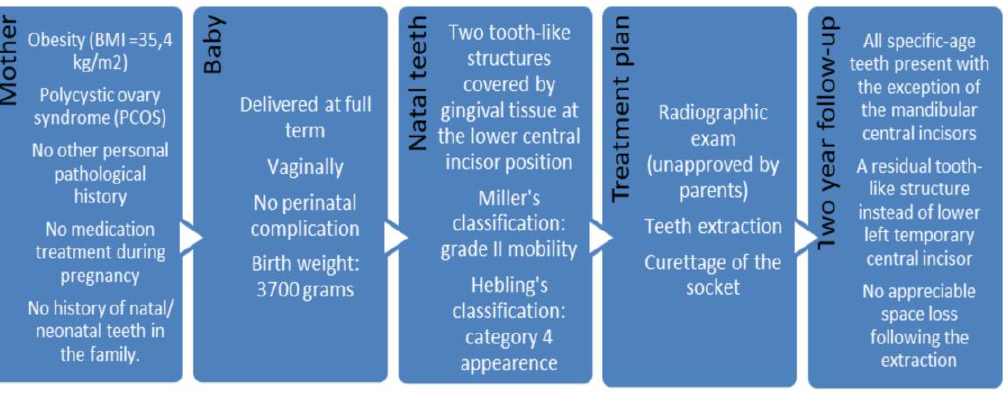
Figure 4. Clinical follow-up done after two